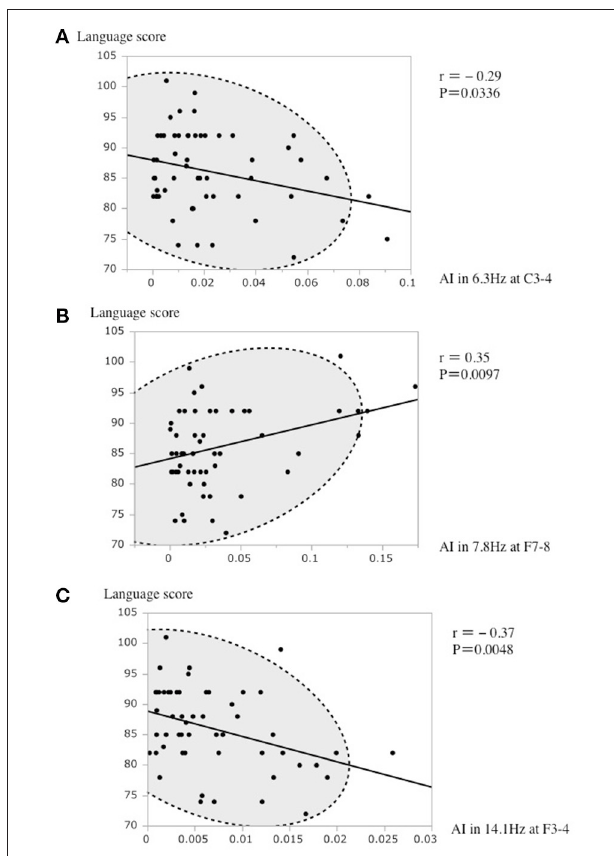
FIGURE 3 | (A) A scatterplot of the AI in 6.3Hz at C3–4 and the language score. (B) A scatterplot of the AI in 7.8Hz at F7–8 and the language score. (C) A scatterplot of the AI in 14.1Hz at F3–4 and the language score. The broken elliptical shape indicates a 95% confidence ellipse for normally distributed data.